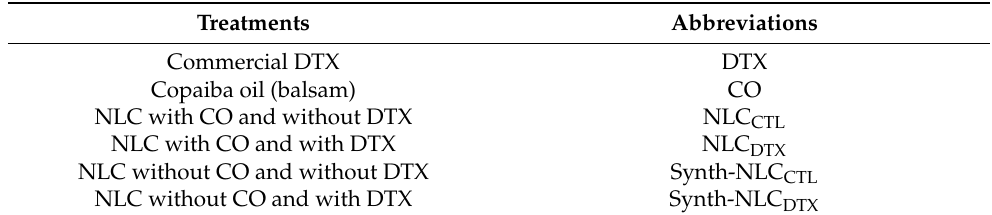
Table 5. In vitro treatment groups. The commercial DTX (containing 20 mg mL − 1 ) was a gift